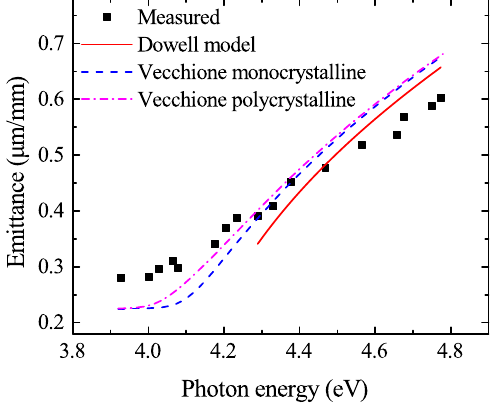
FIG. 5. Measured transverse emittance of TiN film as a function of the photon energies. The work functions obtained from fitting with the Dowell model [13] and the Vecchione monocrystalline model [35] are 4.11 and 4.08 eV, respectively; and from the Vecchione polycrystalline model fit [35] the work functions are in the range of 4.00 – 4.16 eV.